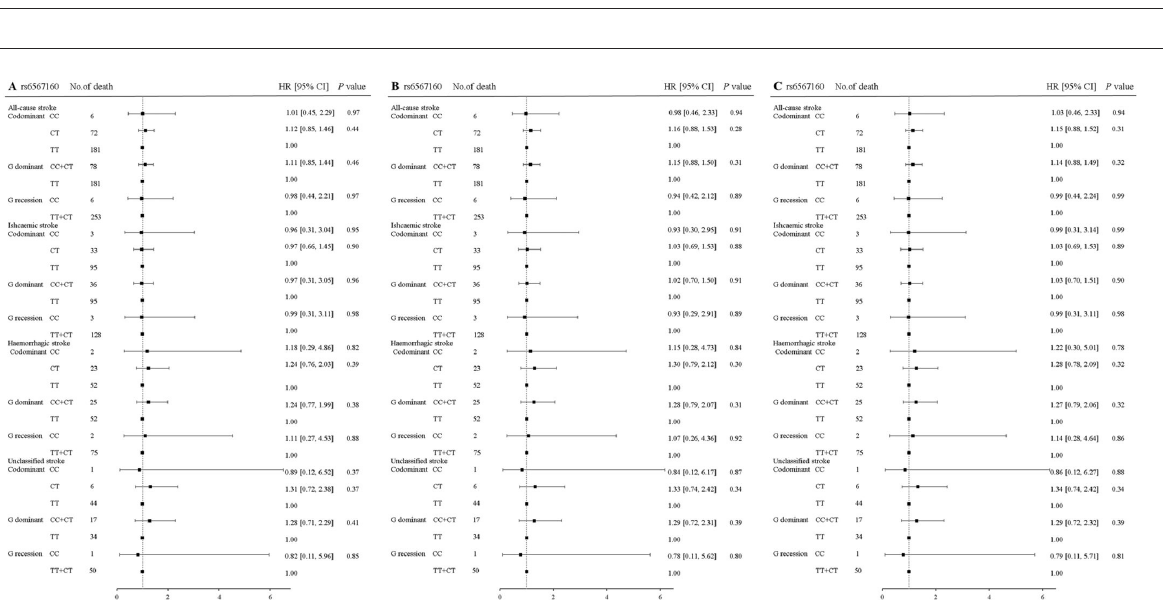
FIGURE3 Association of rs6567160 at the MC4R with the risk of fatal stroke in the participants of the GBCS ( n = 13,967). (A–C) plots the hazard ratios and 95% confidence intervals for the three genotype models alongside the P -values. Model A: crude HR; Model B: adjusted for age, sex, education, job, smoking, alcohol consumption, BMI, physical activity; Model C: adjusted for age, sex, education, job, smoking, alcohol consumption, BMI, physical activity, hypertension, diabetes, and dyslipidemia. * P <